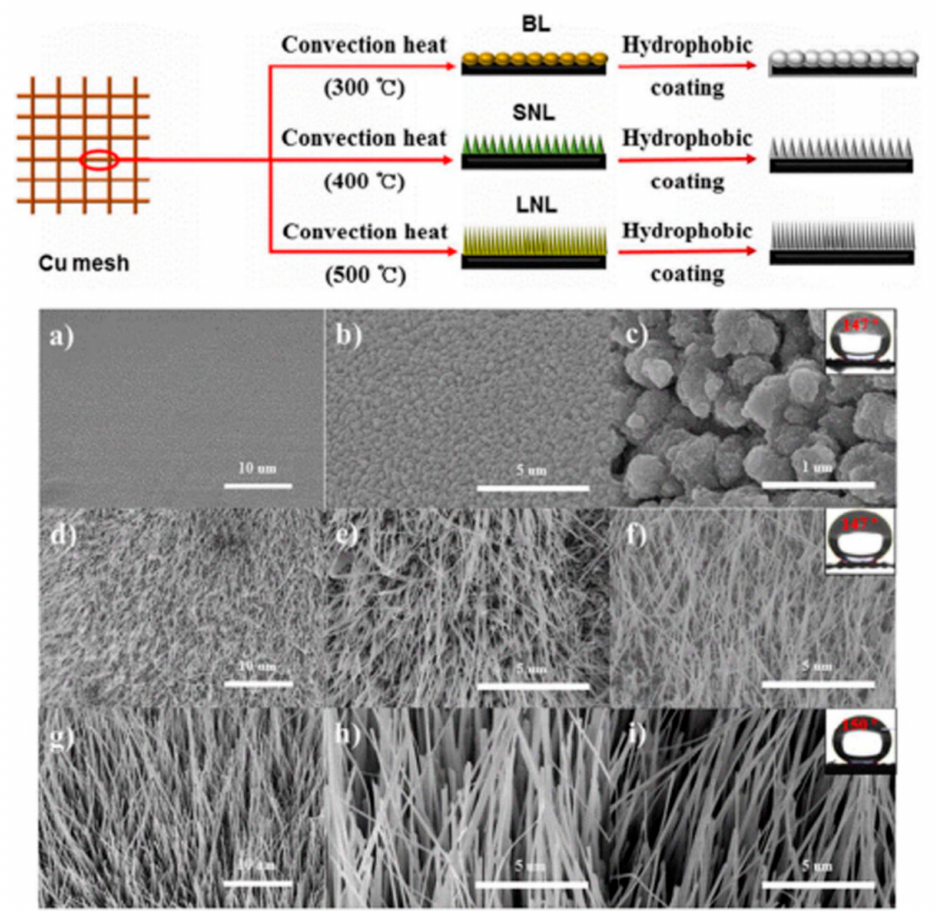
Figure 8. ( Top ) The schematic illustration of the hierarchically oxidized copper meshes formed by heat treatments. ( Bottom ) SEM images of the hierarchically oxidized copper meshes ( a , b , d , e , g , h ) before and ( c , f , i ) after a hydrophobic coating was applied: ( a , b ) bumpy-like (BL)-, ( d , e ) short needle-like (NL)-, and ( g , h ) long NL-Cu meshes synthesized at reaction temperatures of ( a , b ) 300 ◦ C, ( d , e ) 400 ◦ C, and ( g , h ) 500 ◦ C, respectively. Reproduced with permission from [163]. Copyright 2017 American Chemical